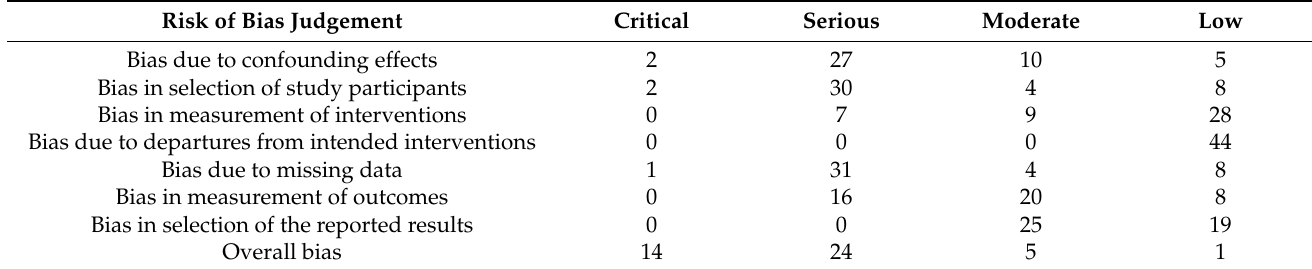
Table 5. Risk of bias judgment outcomes of all selected studies (n =